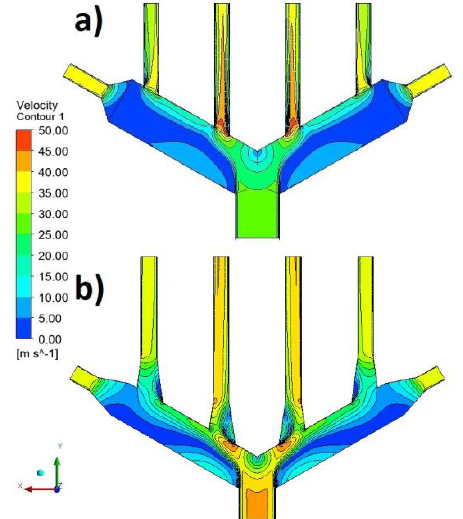
Fig. 10. Contour of the velocity distribution for the reference design (a) and the prototype (b) - the symmetry plane